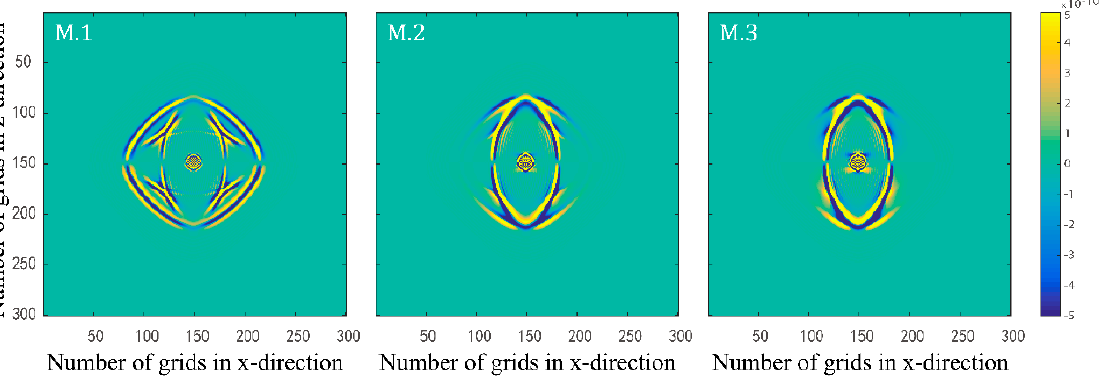
Figure 2. Snapshots of liquid phase z–direction velocity components with three different fluid viscosity coefficients at t = 0.15